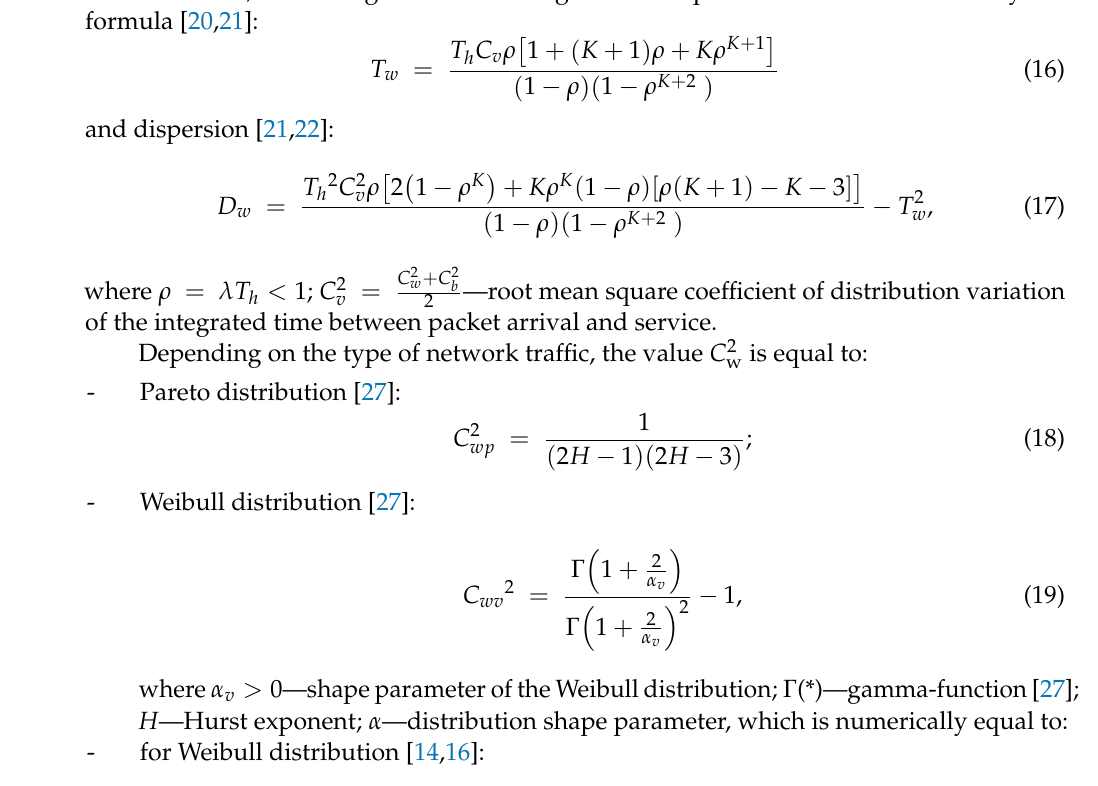
—root mean square coefficient of distribution